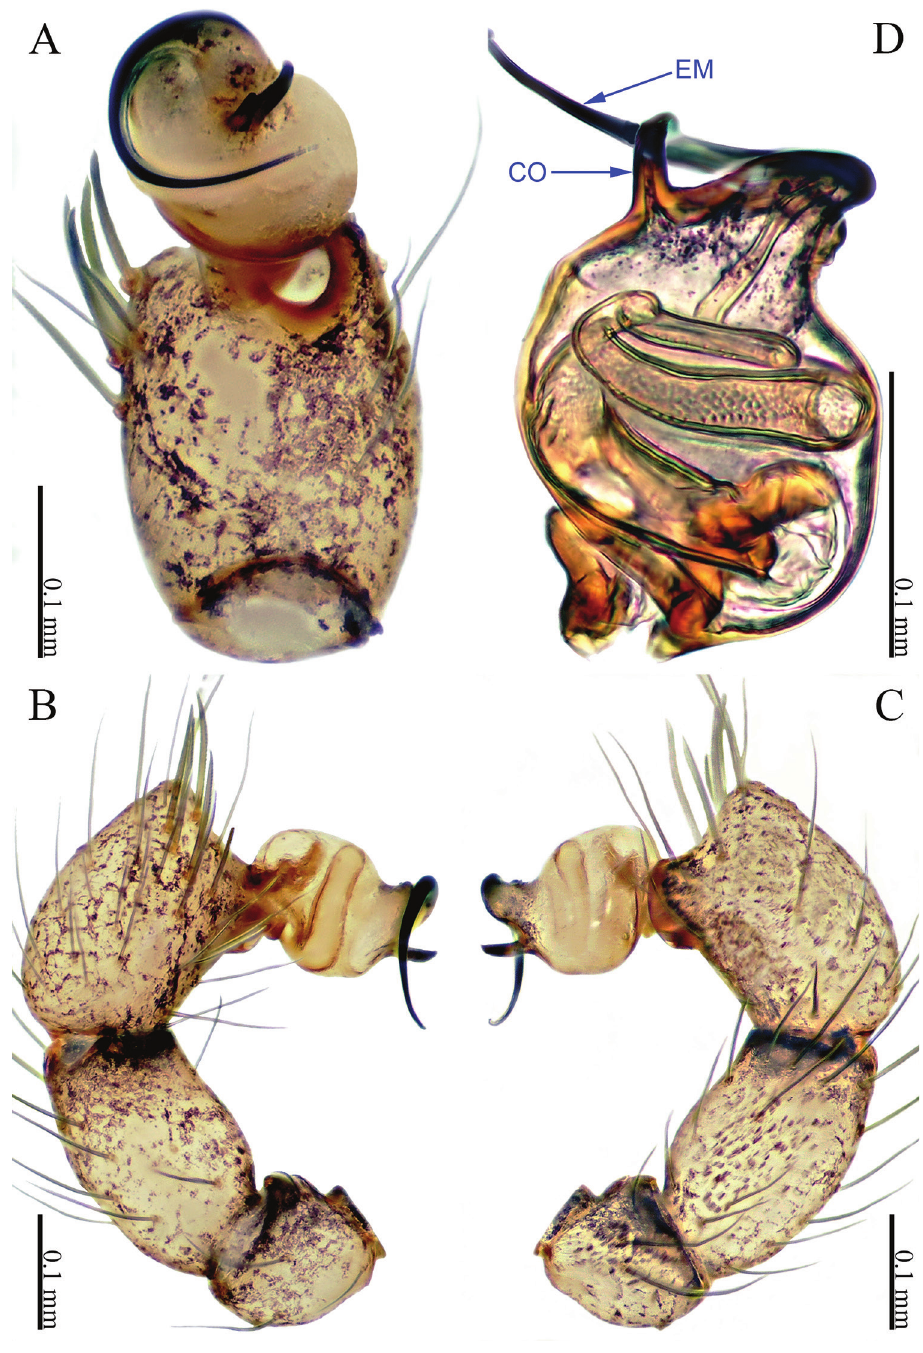
Figure 11. Sinoderces taichi Li & Li, sp. nov., male holotype A palp, ventral view B palp, prolateral view C palp, retrolateral view D palpal bulb, ventral view Abbreviations: CO conductor, EM